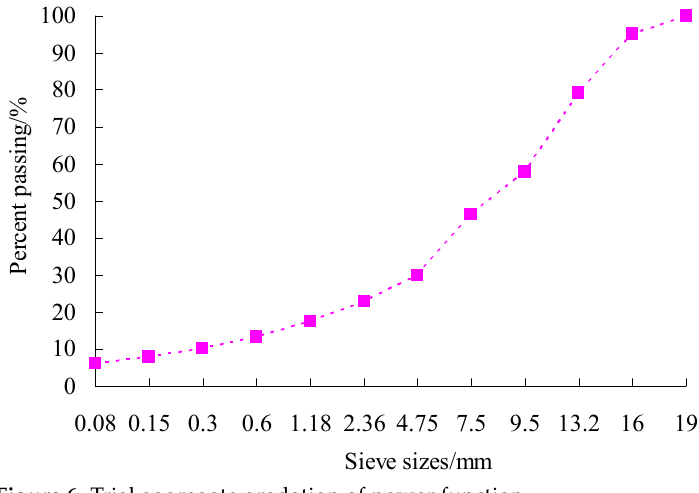
Figure 6. Trial aggregate gradation of power function.